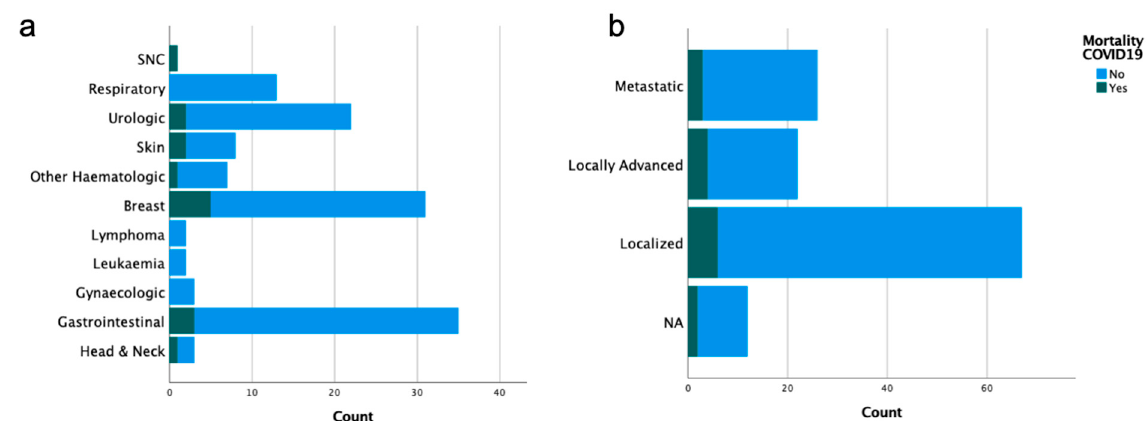
Figure 6. Oncological characteristics distributed by COVID-19 mortality: ( a ) type of oncological tumor; and ( b ) stage of the disease.